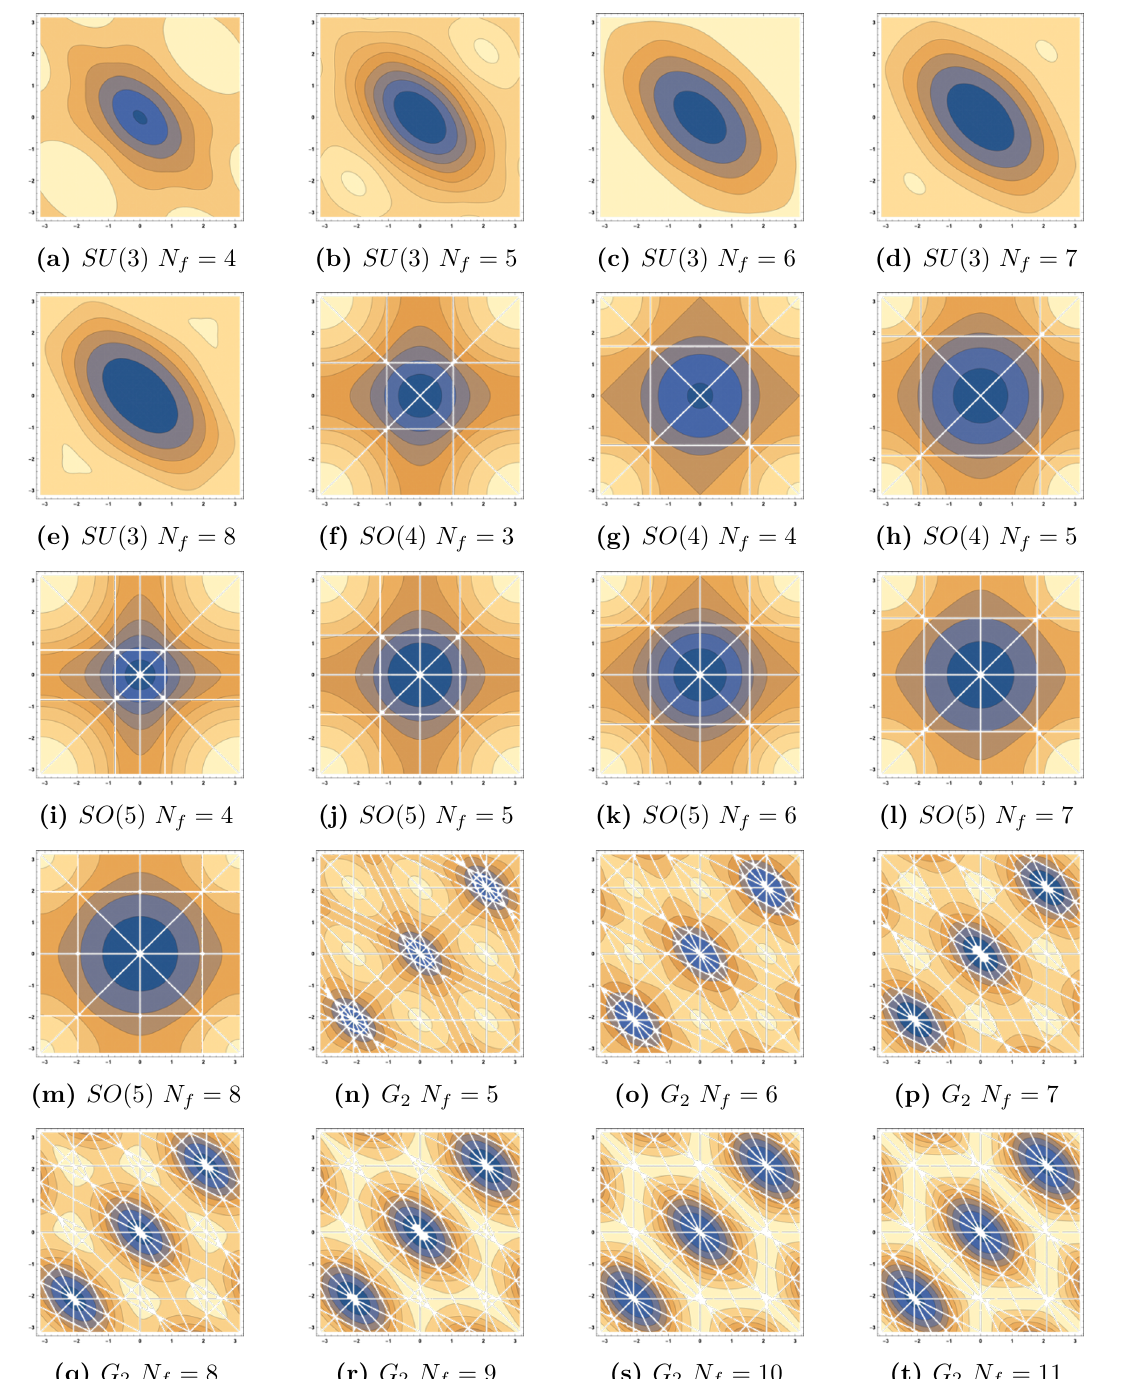
Figure 2. The contour plots of Im F| ∆= − iπ for rank-2 SQCDs. The brighter/darker region has bigger/smaller value. The Sp (2) plots are omitted since F N f lines are located at the cusps at which the Li 3 function jumps between the branches of (2.25). The function is still smooth, and no additional saddle point exists on those